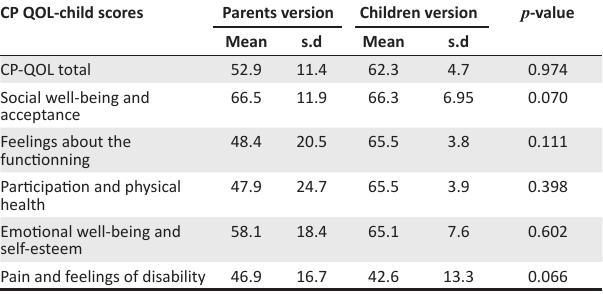
TABLE 4: Relationship between quality of life in children with cerebral palsy and socio-demographic, economic, clinical and therapeutic information. Biographical